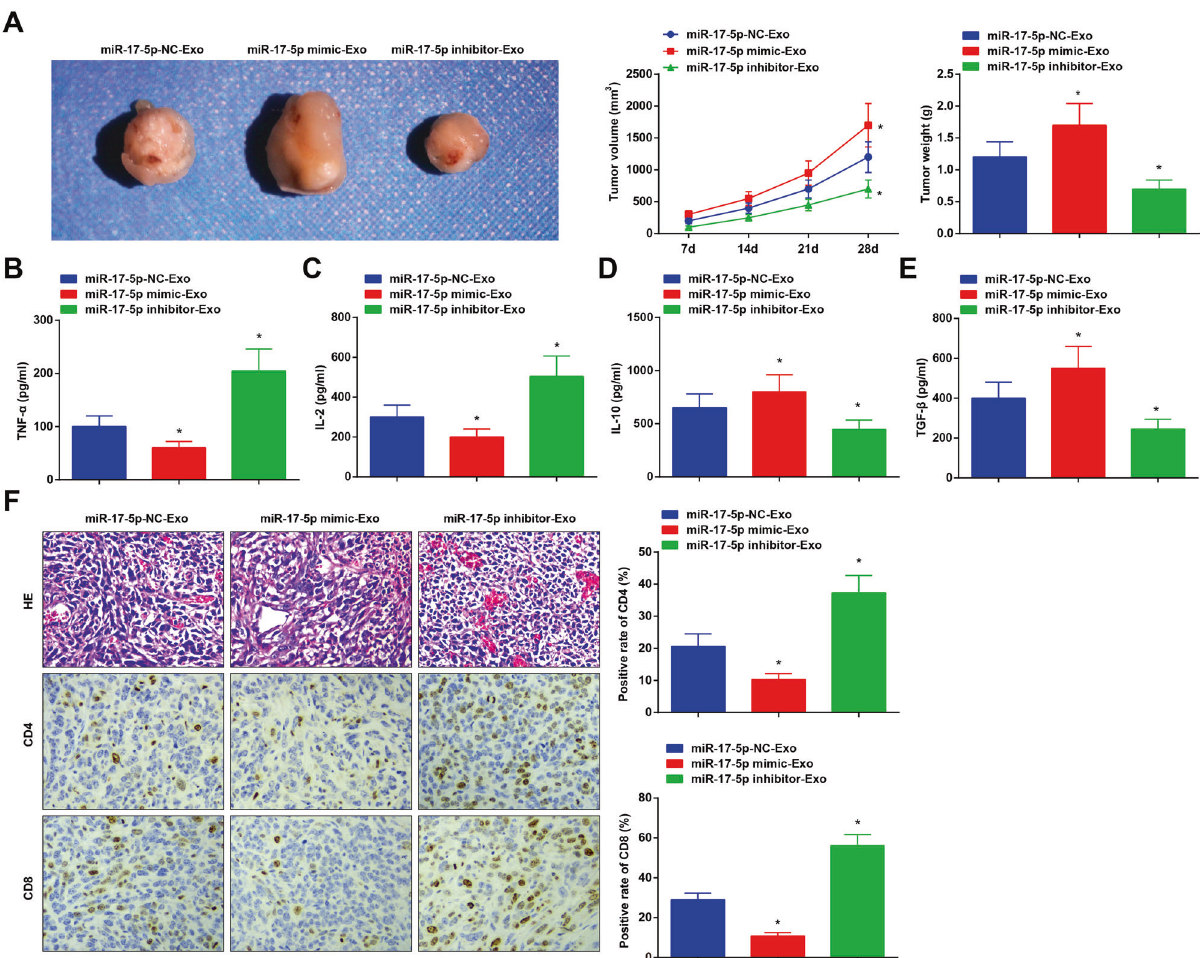
Fig. 5 CRCSC-exos upregulating miR-17-5p suppresses anti-tumor immunity in CRC. A Representative images, volume, and weight of xenografts from mice after treated with CRCSC-exos transmitting miR-17-5p mimic/inhibitor; B – E TNF- α , IL-2, IL-10, and TGF- β contents in mouse serum determined using ELISA 72 h after exosome injection; F the histological characteristics of tumor tissues detected using HE staining; CD4 and CD8 expression in xenografts from mice detected using immunohistochemistry after treated with CRCSC-exos transmitting miR-17-5p mimic/inhibitor. There were fi ve mice in each group. * P < 0.05 vs the miR-17-5p-NC-Exo group; the measurement data were expressed as mean ± standard